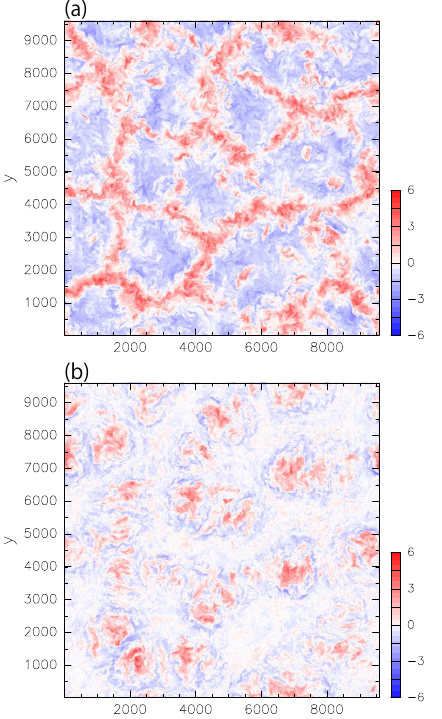
Figure 3. Horizontal cross section of the vertical velocity at (a) 500m and (b) 1200m height in the 10mAR1 run of the con- trol experiment.